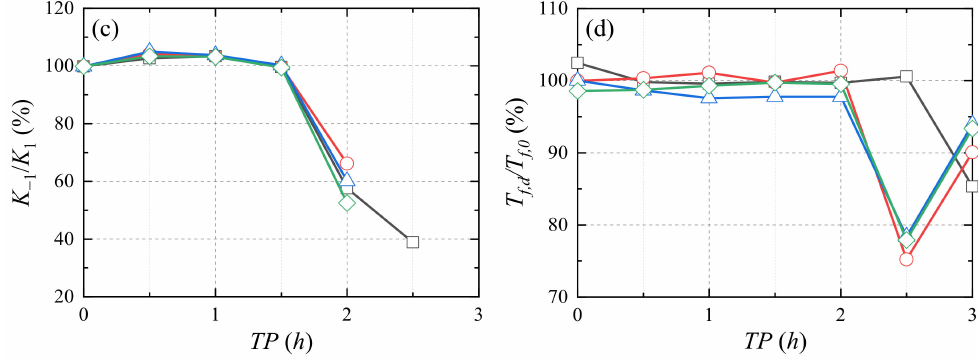
Figure 22. Impact of cyclic load on the response of RC column with different tie spacing ( sp ) during fire exposure: ( a ) cyclic load effect coefficient η ; ( b ) MAPE ; ( c ) stiffness degradation ratio; ( d ) fire resistance time ratio.